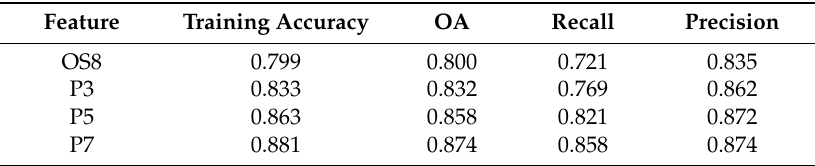
Table 9. Accuracy evaluation based on SVM-L2.